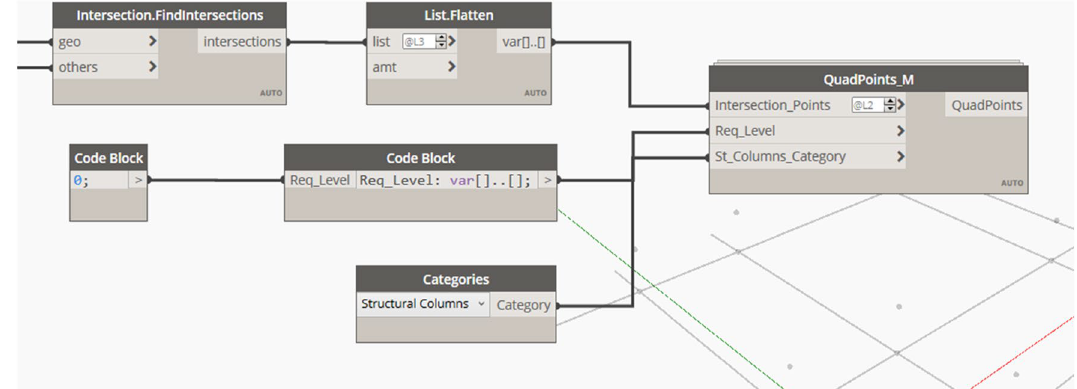
Figure 6. Subdivided quad points arrangement custom node (Screenshot from the coding on